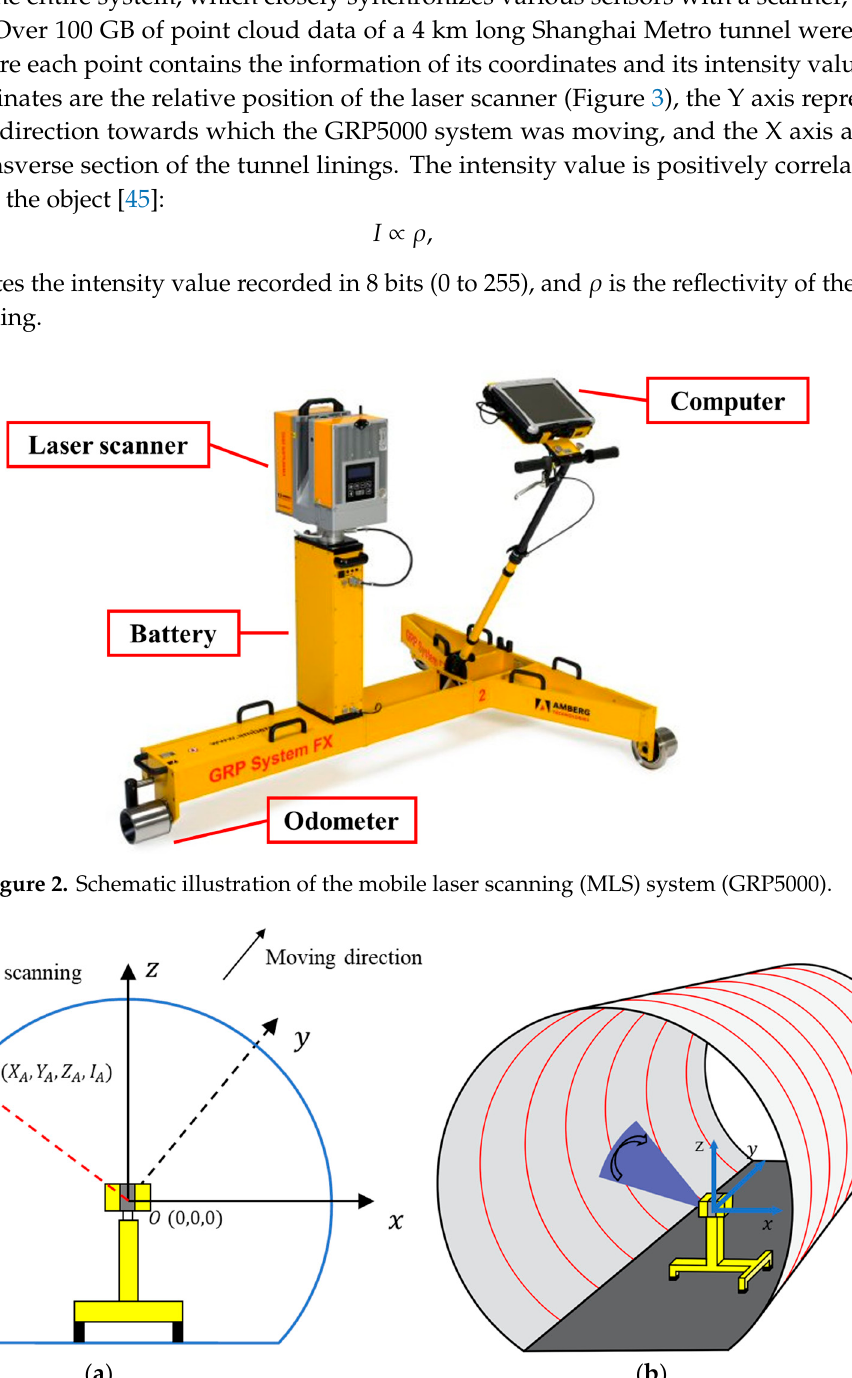
Figure 3. Relative coordinates of the MLS system: ( a ) principle of the tunnel profile scanning; ( b ) scanning in the 3D space.